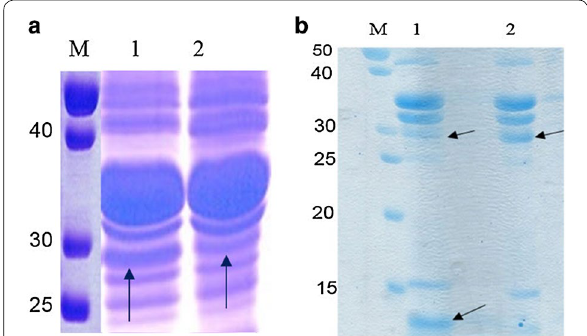
Fig. 5 Fractionation of the surface displaying bacterial cells; a lane 1: outer membrane fraction of the cell surface from recombinant E. coli without sortase treatment. The band corresponding to the whole chimeric protein is indicated with arrow. a Lane 2: outer membrane fraction of the cell surface from E. coli after treatment with